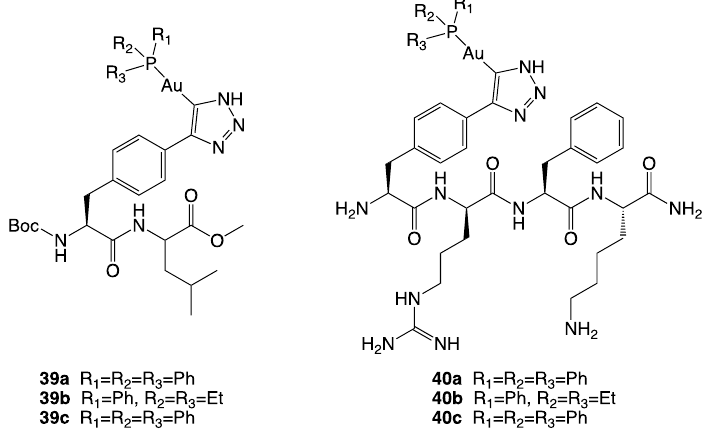
Figure 22. Structures of complexes 39a – c and 40a – c .